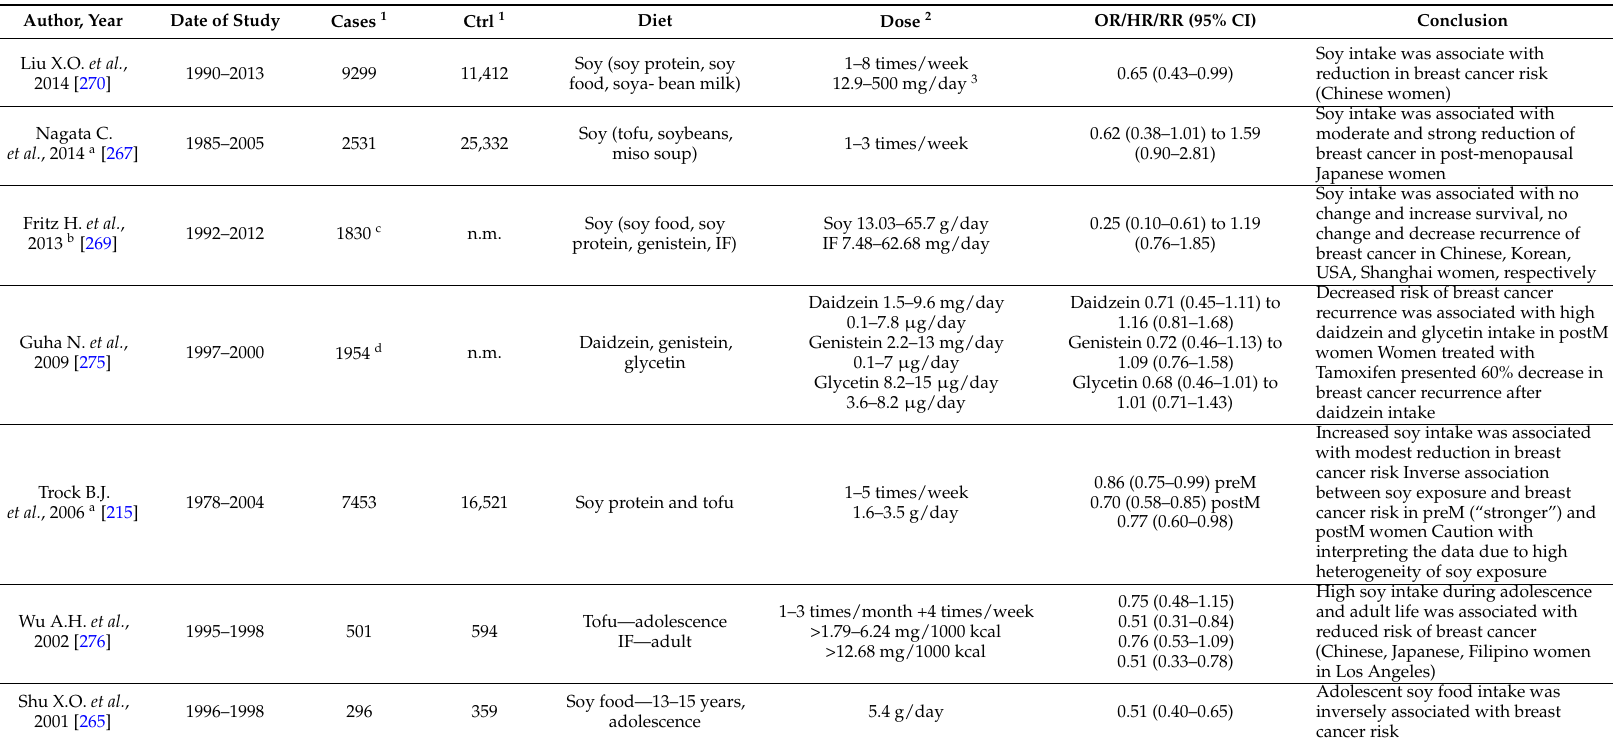
Table 5. Summary of the association between breast cancer risk and soy